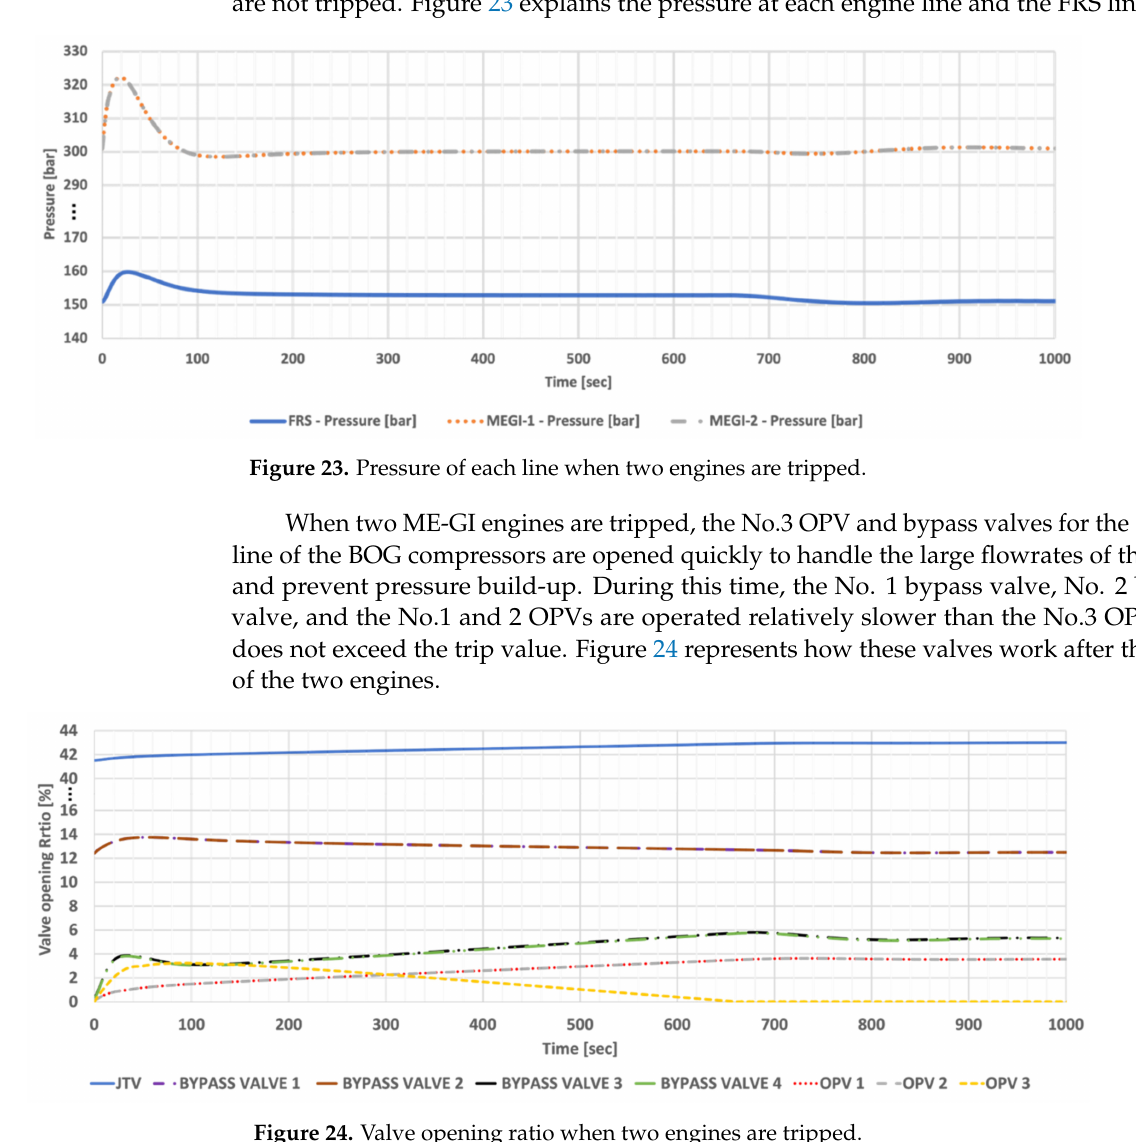
Figure 24. Valve opening ratio when two engines are